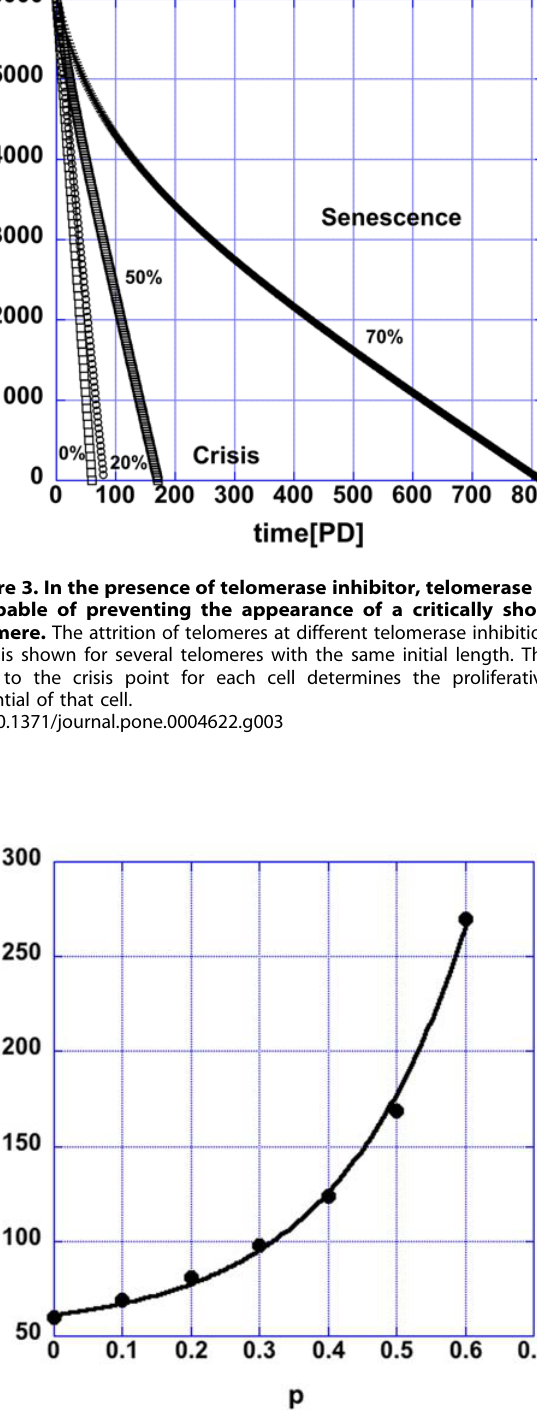
Figure 4. The average proliferative potential or the number of cell divisions before crisis of a population of cells is shown as a function of the degree of telomerase inhibition p . The parameter p describes the availability of telomerase and varies between 0 (no telomerase is available) and 1 (all telomerase is available). The proliferative potential is averaged over 1000 cells for each inhibition level and the functional dependence is well approximated by an exponential function in the interval p=0.0 to p=0.6: V=V 0 + V 1 exp(p/p 0 ) (V 0 =52, V 1 =8, and p 0 =0.17, R=0.99816).